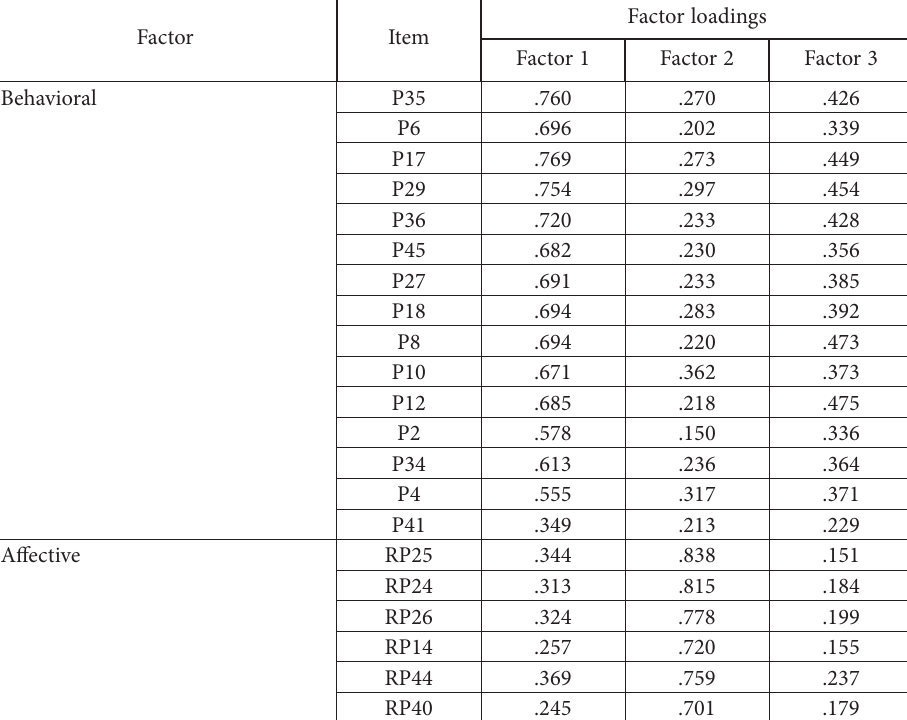
Table 1. Factor loadings according to exploratory factor analysis for the 45 items of attitudes towards creative persons (source: created by authors)